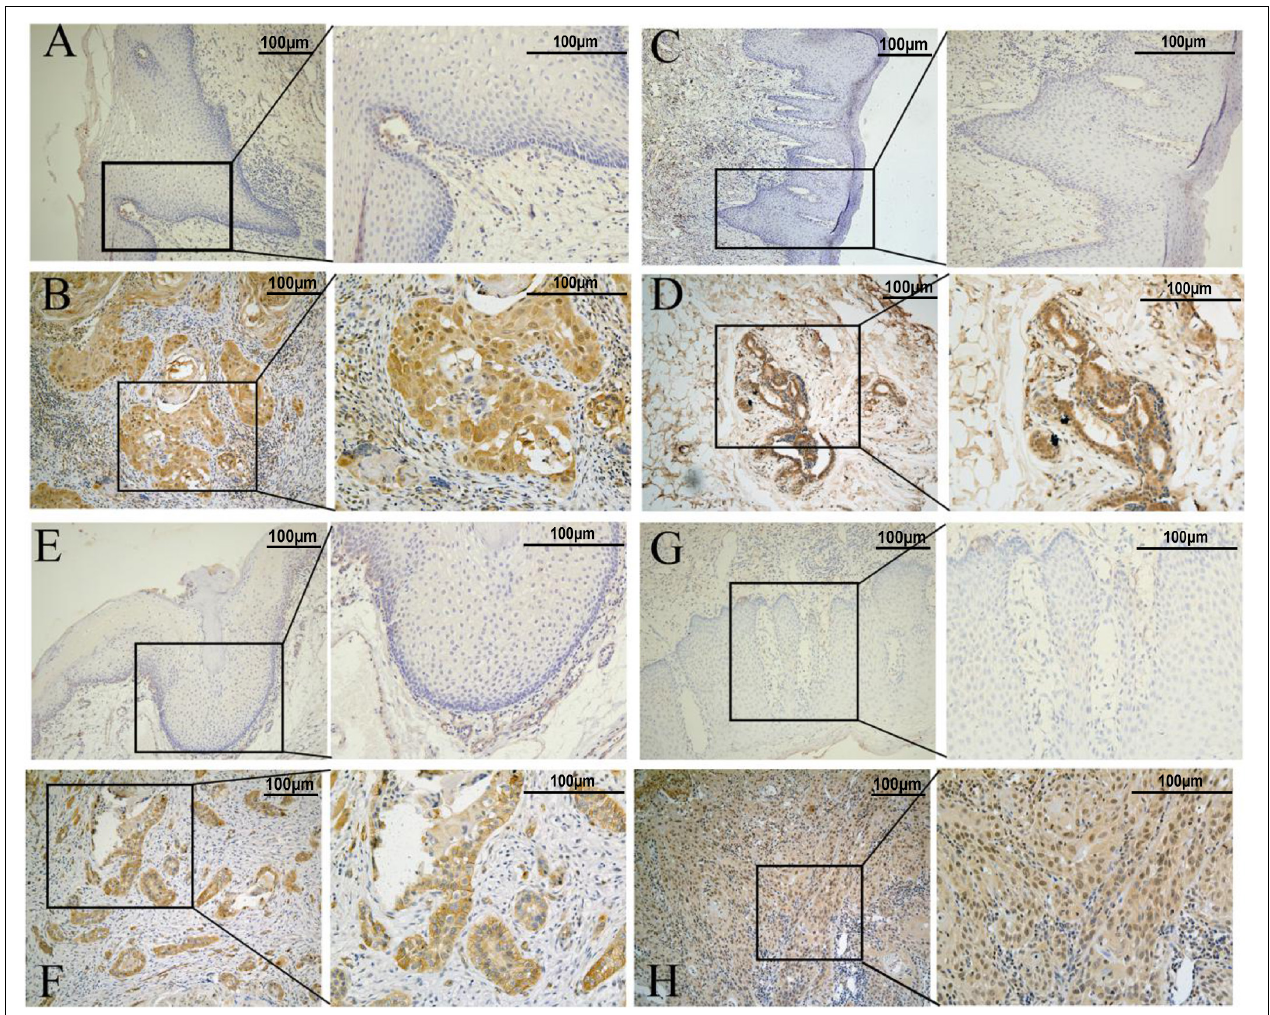
FIGURE 11 | Representative immunohistochemistry results. (A,C,E,G) represent normal tissue. (B,D,F,H) represents tumor tissue (the scale bar represents 100 µ m). (A,B) AKR1C3 protein. (C,D) AURKA protein. (E,F) CAV1protein. (G,H) TRIB3